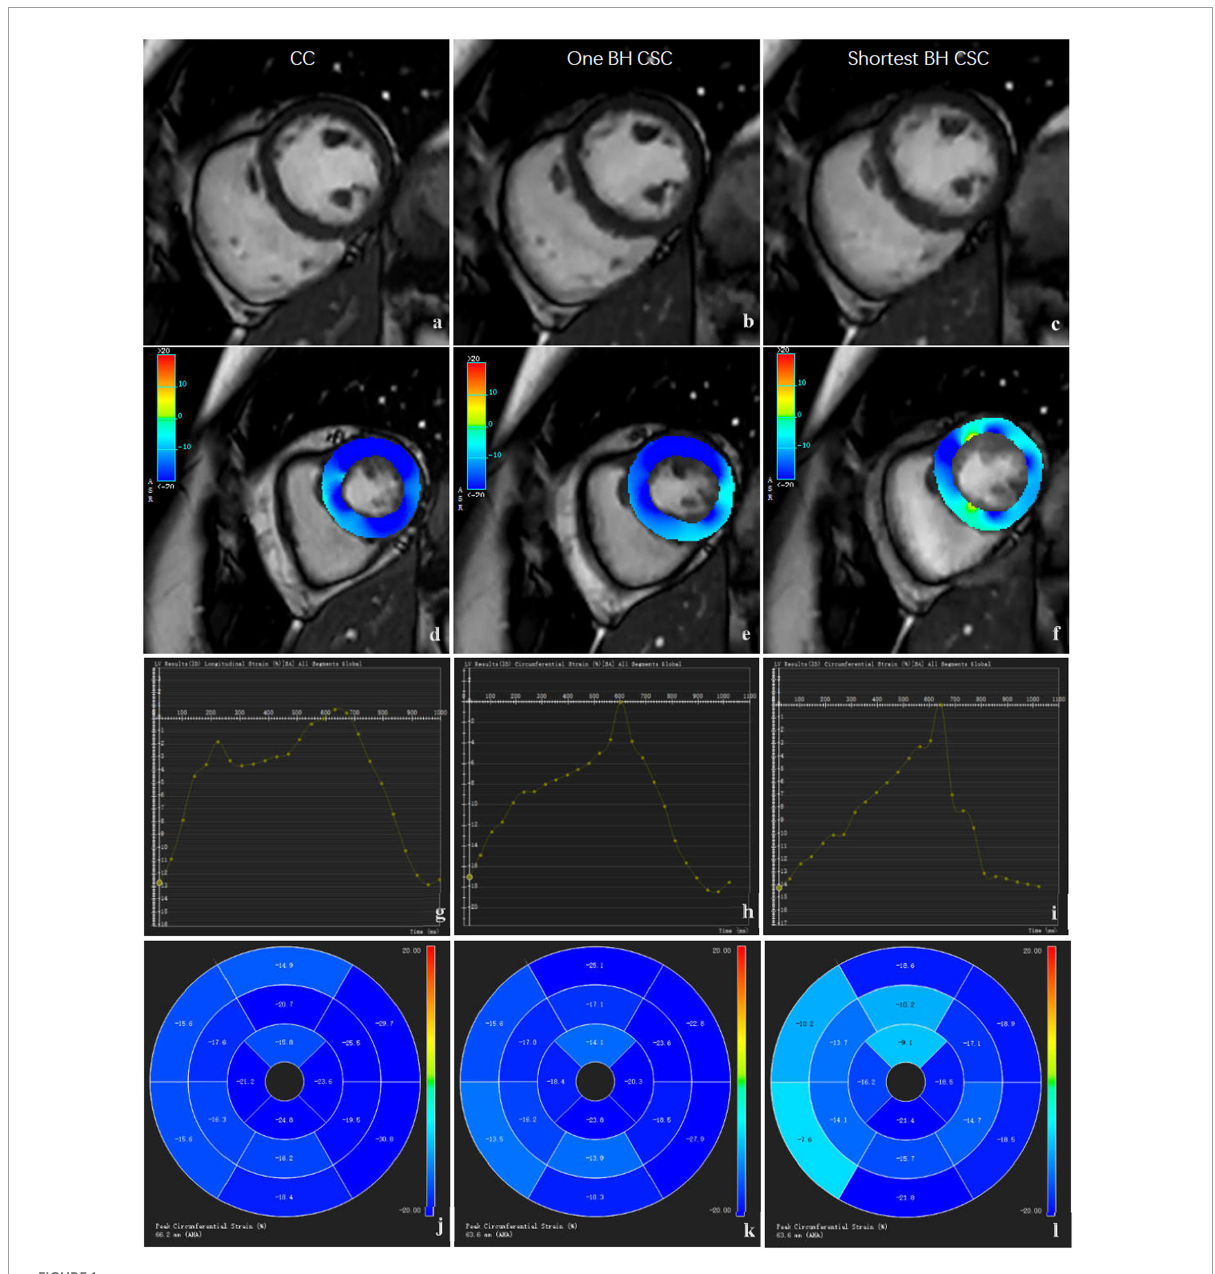
FIGURE1 Comparison of SA images and strain analysis by different protocols. The images in left column (a,d,g,j) , middle column (b,e,h,k) , and right column (c,f,i,l) were acquired by CC protocols. The original SA images (a,b,c) are shown in the first row, strain color images (d,e,f) are shown in the second row, global strain curve (g,h,i) are shown in the third row, and regional strain polar maps (j,k,l) are shown in the fourth row.